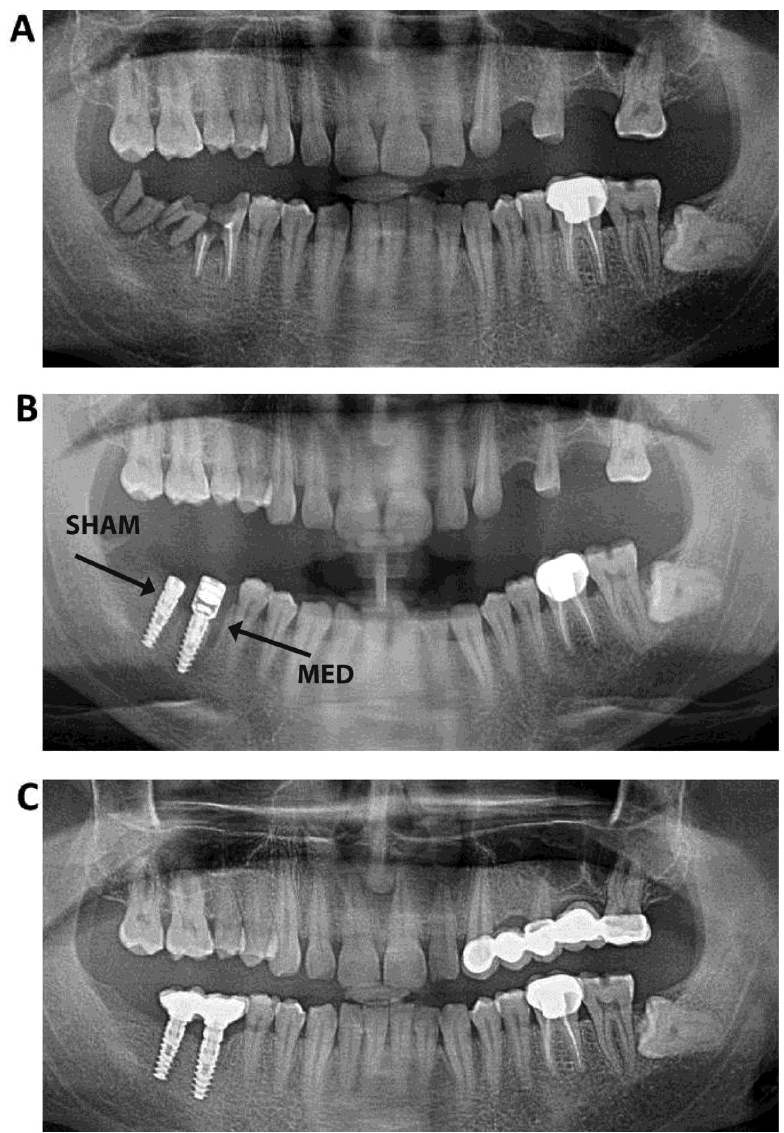
Figure 1. Radiographic appearance of a miniaturized electromagnetic device (MED; test) and sham (control) healing abutments, ( a ) before the implantation; ( b ) 6 weeks post-implantation and ( c ) 12 weeks post-implantation.